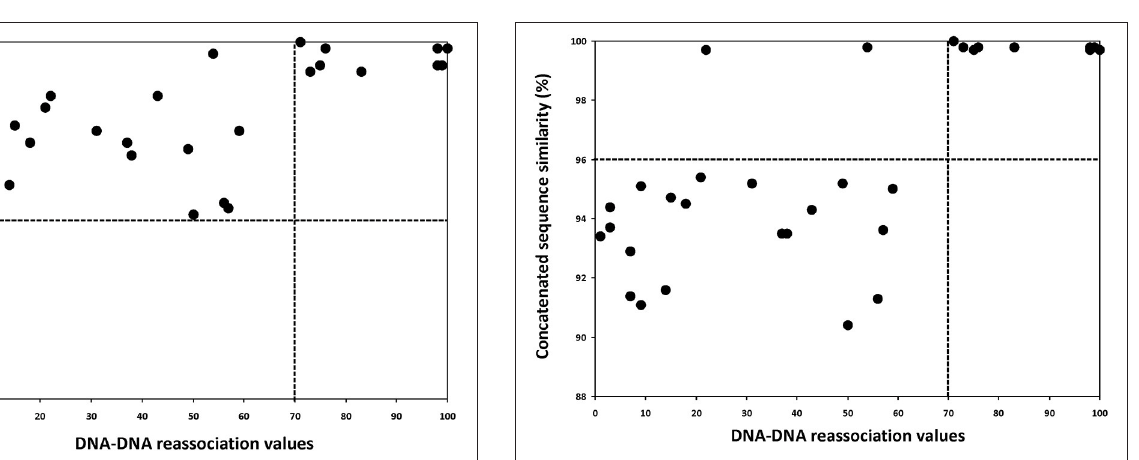
FIGURE 6 | Graph of the five concatenated gene sequence similarity vs. DDH relatedness values for the genus Halorubrum . The vertical dashed line indicates the 70% DDH threshold, while the horizontal dashed line indicates the proposed genetic similarity threshold for distinguishing genomic species. The two points above the 96% limit and below 70% DDH are pairwise comparisons of Hrr. chaoviator Halo-G* T /DSM 19316 T vs. Halorubrum sp. Fb21 and Hrr. ezzemoulense DSM 17463 T vs. Halorubrum sp.